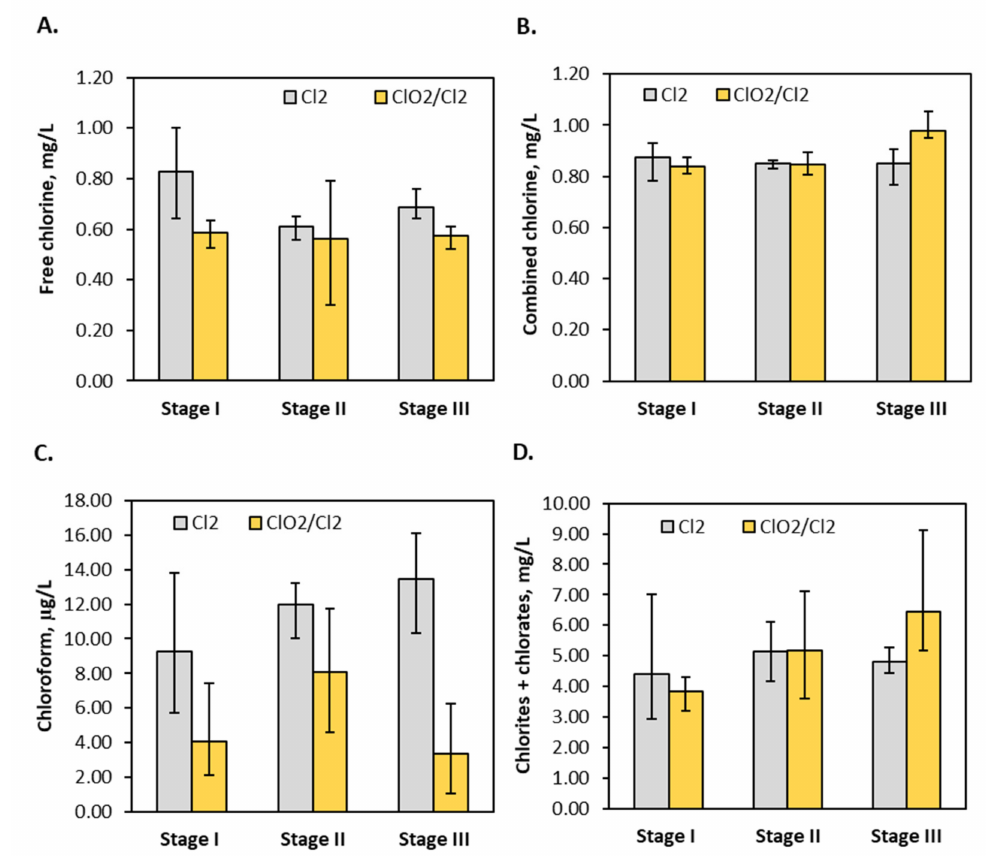
Figure 2. The influence of chlorine dioxide on the physical and chemical parameters of swimming pool water: ( A ) free chlorine; ( B ) combined chlorine; ( C ) chloroform; ( D ) sum of chlorates and